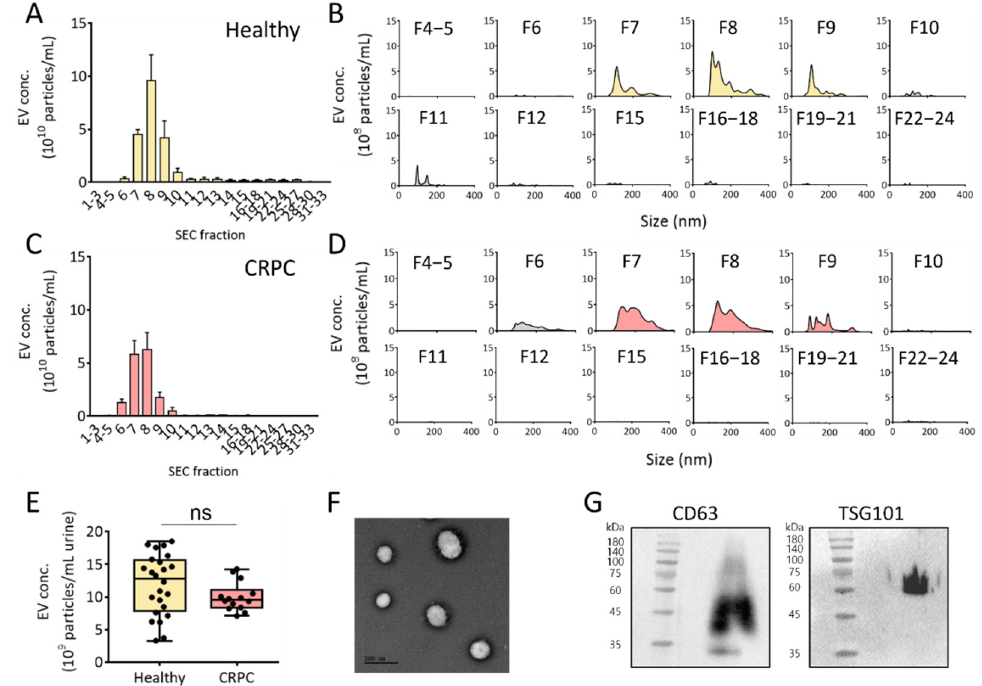
Figure 3. Isolation of urinary EVs via size-exclusion chromatography combined with UF from healthy donors and patients with CRPC. ( A ) Urinary EV concentration (EV particles/mL fraction) from healthy donors. ( B ) Urinary EV size distribution from healthy donors in all size-exclusion chromatography fractions. ( C ) Urinary EV concentration (EV particles/mL fraction) from patients with CRPC. ( D ) Urinary EV size distribution from patients with CRPC in all size-exclusion chromatography fractions. ( E ) Urinary EV concentration (EV particles/mL urine) from healthy donors and patients with CRPC. ( F ) TEM image of isolated urinary EVs. ( G ) Western blot analysis of the EV marker proteins. The number on the left of blot indicates the size marker. All values are presented as the median ± SD (ns: no significance; n = 3–24).